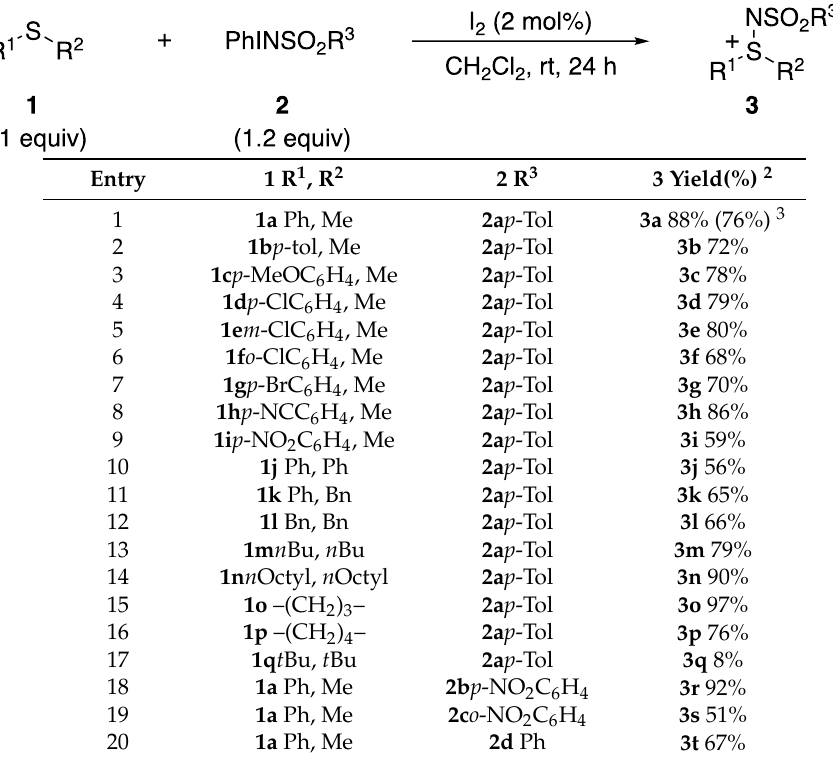
Table 2. Metal-free imination reaction of thioanisoles 1 with imino- λ 3 -iodane 2 in the presence of I 2 1 .